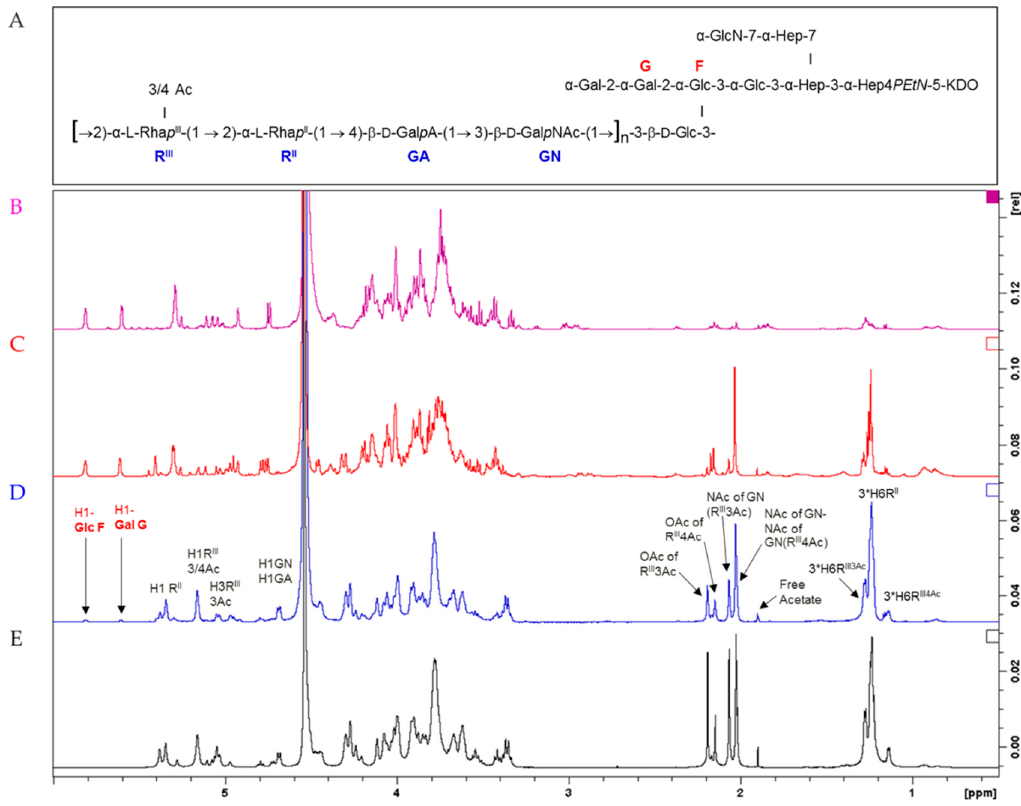
Figure 2. Structure of S. flexneri 6 OAg repeating unit and LPS core region ( A ); 1H NMR spectra of isolated core region ( B ); LMM OAg ( C ); MMM OAg ( D ; HMM G4C ( E ).